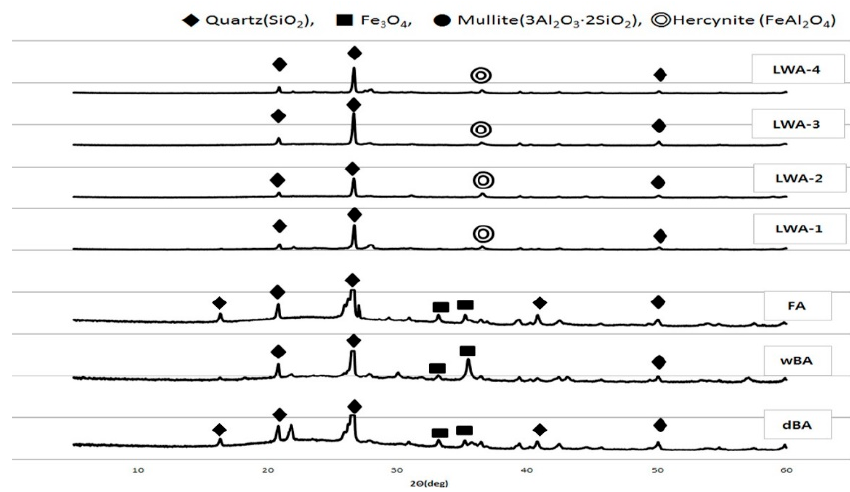
Figure 9. Mineral composition of the test materials.